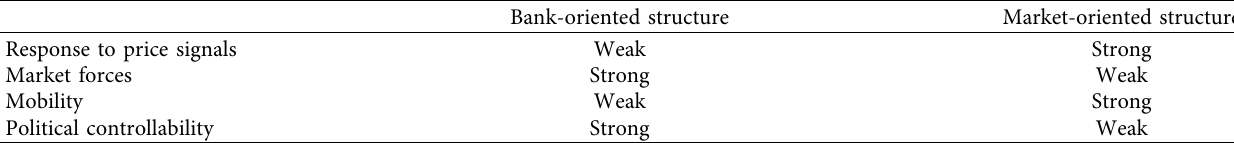
Table 2: The difference between Bank-oriented Structure and Market-oriented